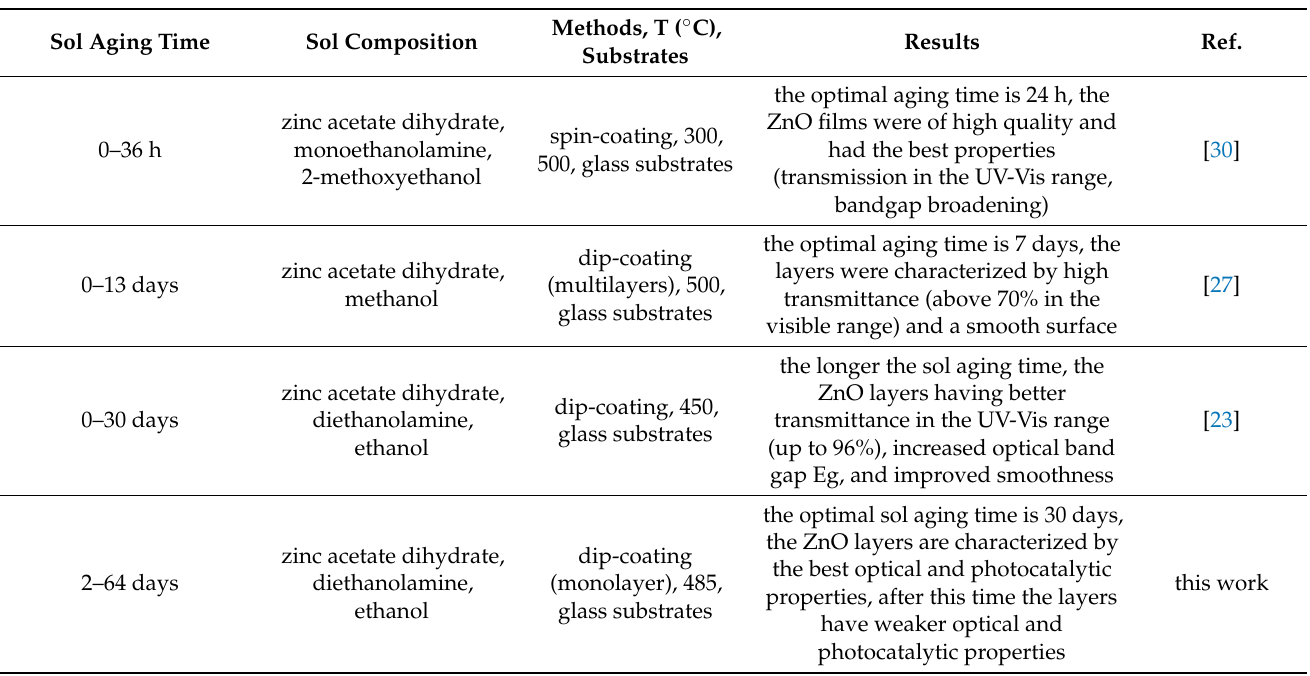
Table 2. Comparison of the present article with published articles based on sol aging time and thin layers